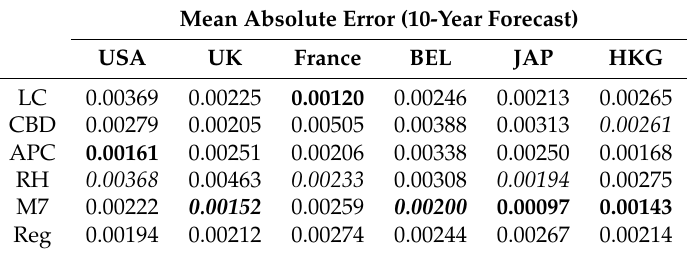
Table 2. Mean Absolute Error for USA, UK, France, Belgium (BEL), Japan (JAP) and Hong Kong (HKG) for the different models of Table 1 and our regularized model (Reg). Fit based on historical data from 1986 to 2007. In bolds: Lowest Mean Absolute Error per Country and in italics: lowest BIC model (excluding